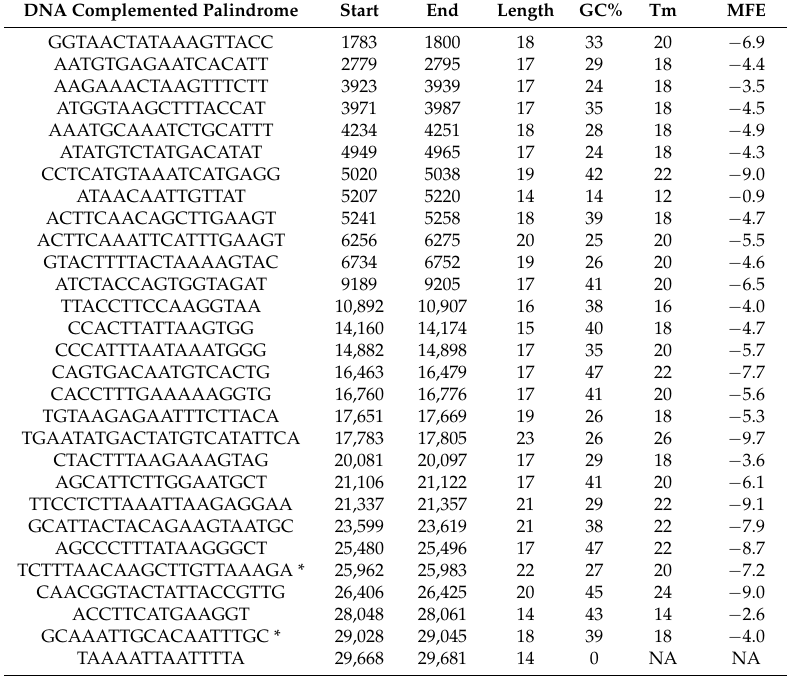
Table 2. DNA complemented palindromes in the severe acute respiratory syndrome coronavirus (SARS-CoV) genome. DNA Complemented